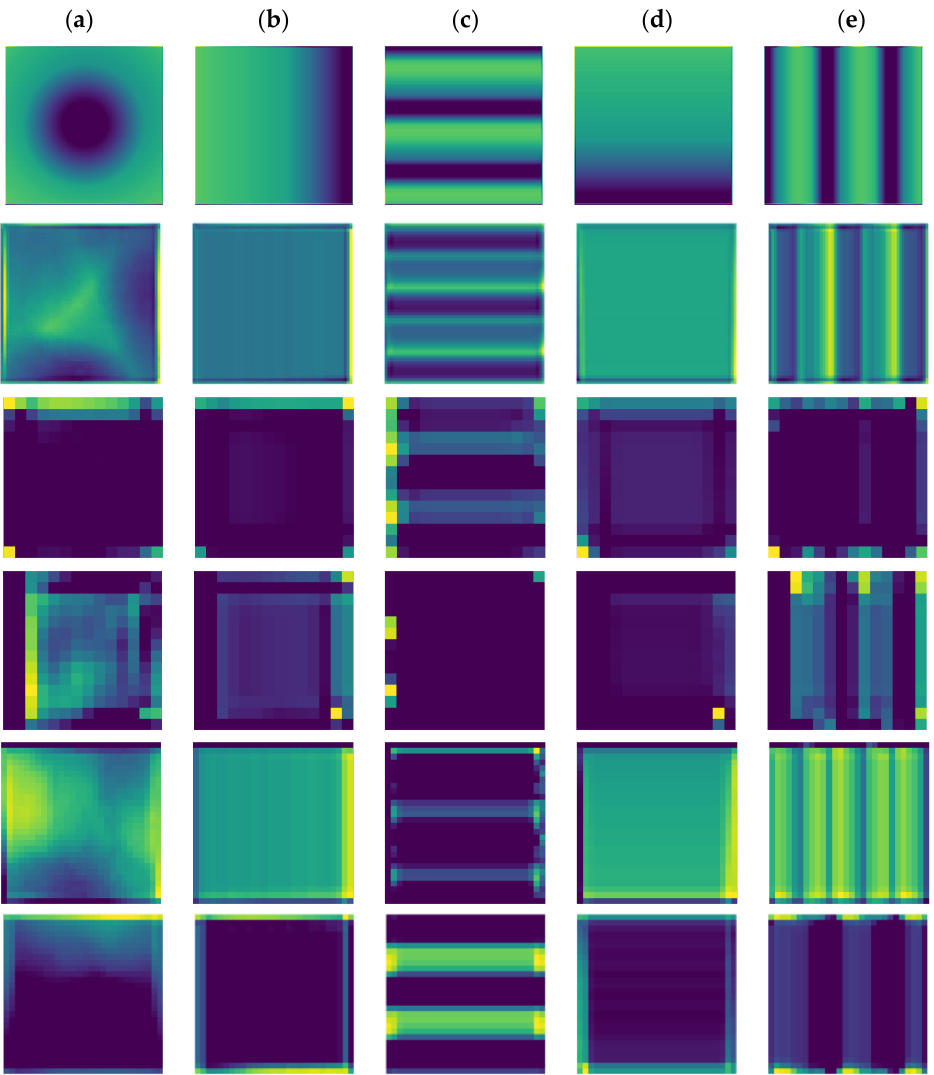
Figure 5. Feature maps. (a-e)Different weight masks in the feature map of the middle layer